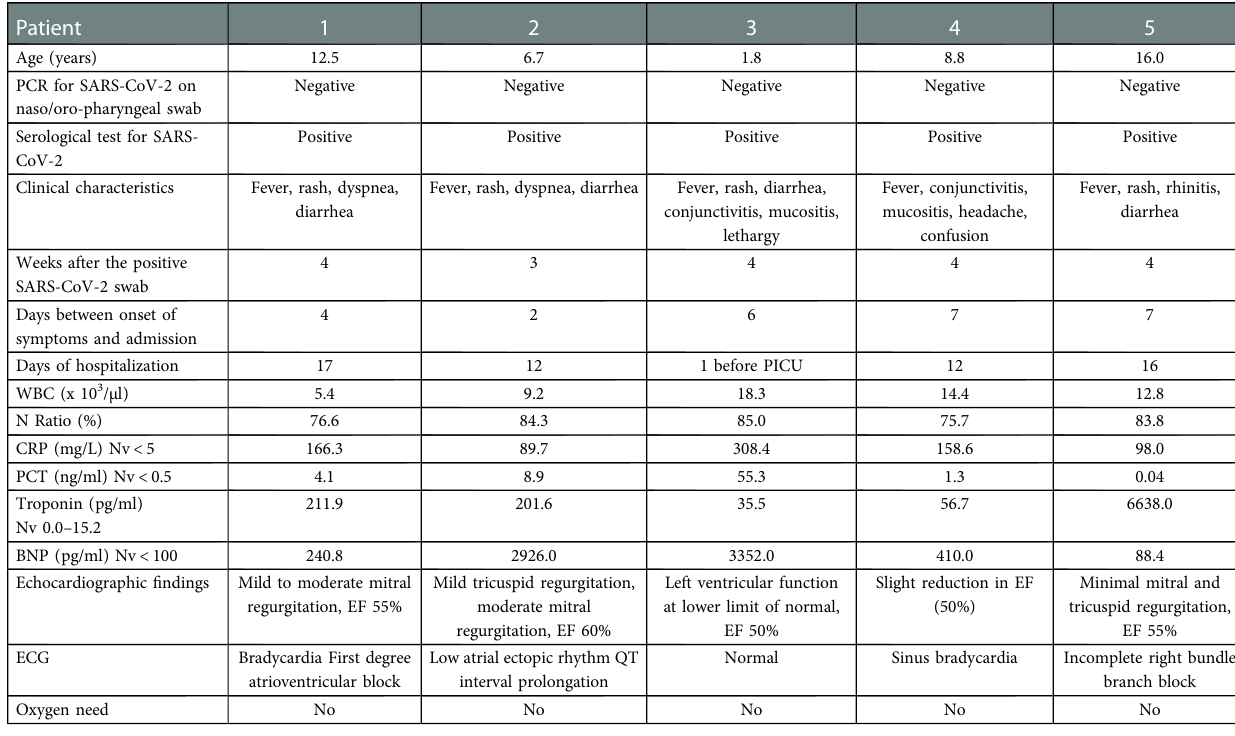
TABLE 1 Clinical, laboratory and cardiac fi ndings and oxygen need of 5 patients with MIS-C.